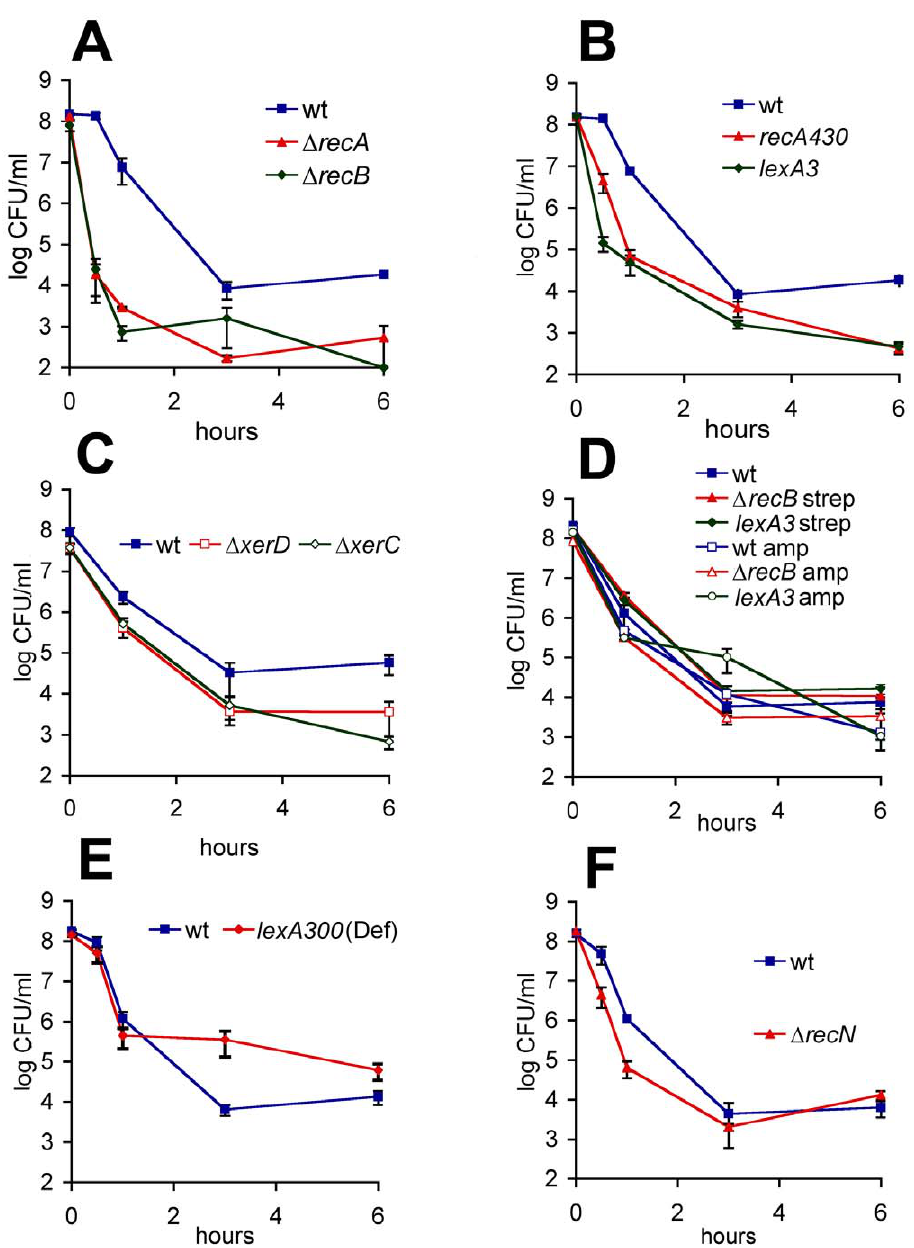
Figure 1. Survival of the wild type and the mutants deficient in recombination and/or SOS induction after ciprofloxacin challenge. Strains were exposed to ciprofloxacin in exponential growth phase. Viable counts were determined by plating. Graphs are representatives of at least 5 independent experiments. Error bars represent standard error.